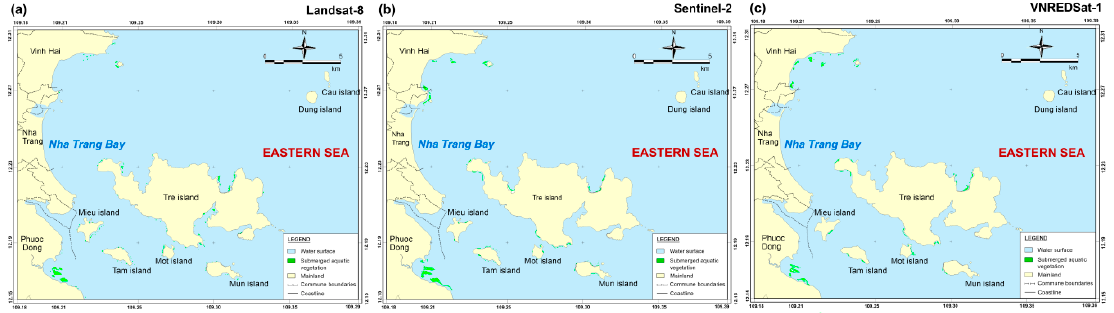
Figure 8. SAV distribution maps for Nha Trang Bay, using data from three satellites: ( a ) Landsat-8 (2018), ( b ) Sentinel-2 (2019), ( c ) VNREDSat-1 (2017).